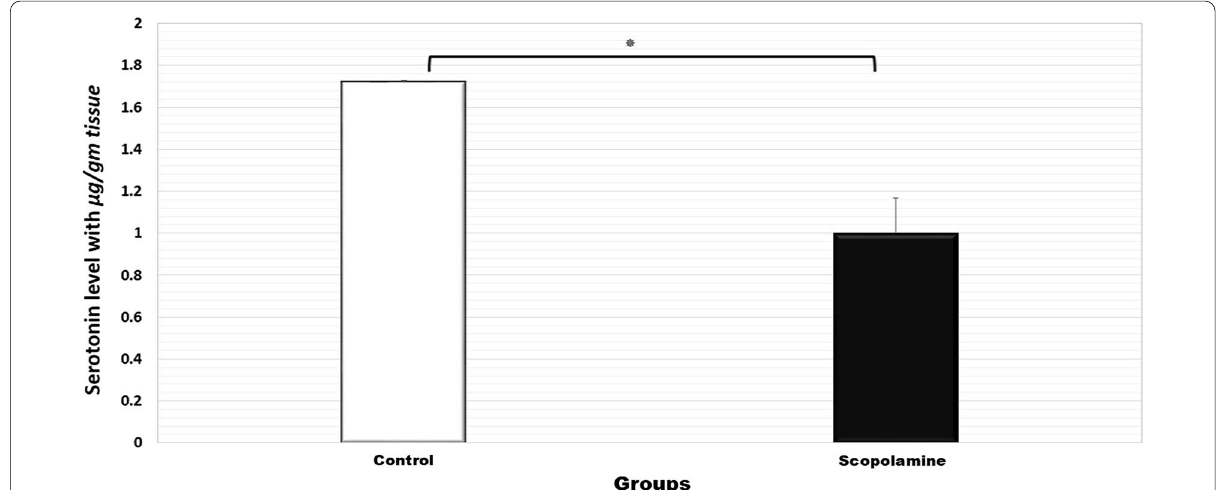
Fig. 4 Effect of long‑term scopolamine treatment on brain serotonin level of rats. Data expressed as means significant difference at P